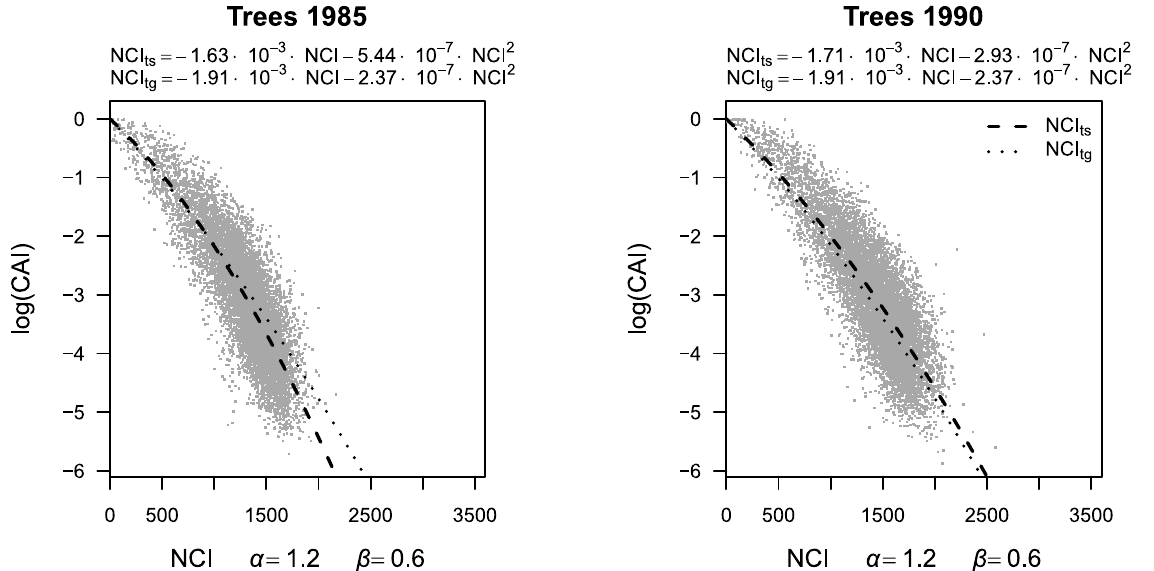
Figure 5. Best neighborhood competition index (NCI, a =1.2, b = 0.6) versus canopy index (CAI). Lines show quantile regressions to convert neighborhood competition index (NCI) into an interval-specific estimate of log(canopy index) (NCI ts , dashed line) or into a general estimate of log(canopy index) which is based on pooled data from both census intervals (NCI tg , dotted line). doi:10.1371/journal.pone.0081787.g005 PLOS ONE |